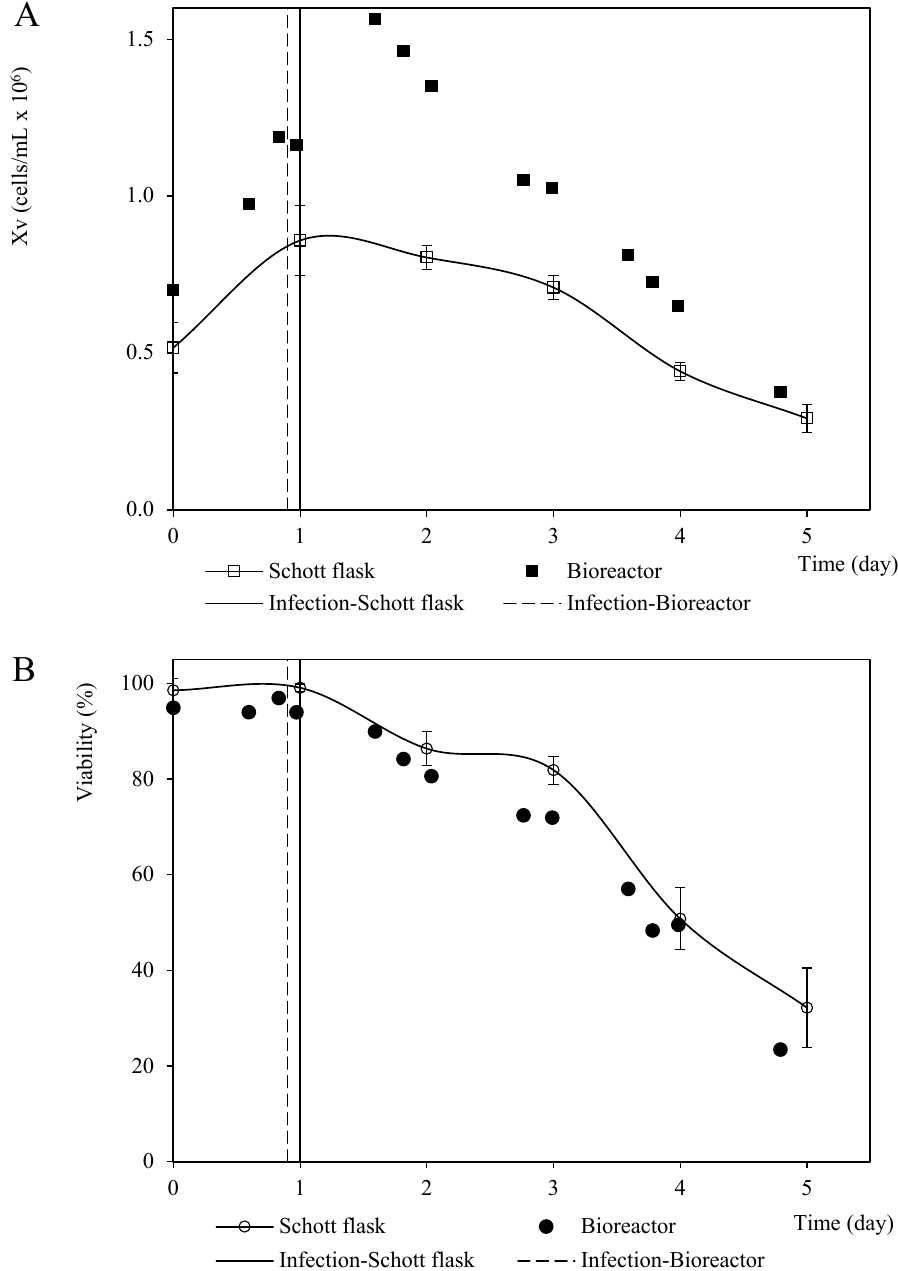
Figure 7. Patterns of viable cell density and viability corresponding to Sf9 cells coinfected with recombinant baculovirus carrying the rabies G glycoprotein and M protein MOI at 3 pfu/cell and 2 pfu/cell, respectively, in Schott flask and bioreactor. ( A ) Viable cell density pattern. ( B ) Viability pattern. The points and error bars from Schott flask assays represent the average and the standard deviation of three repetitions, respectively.